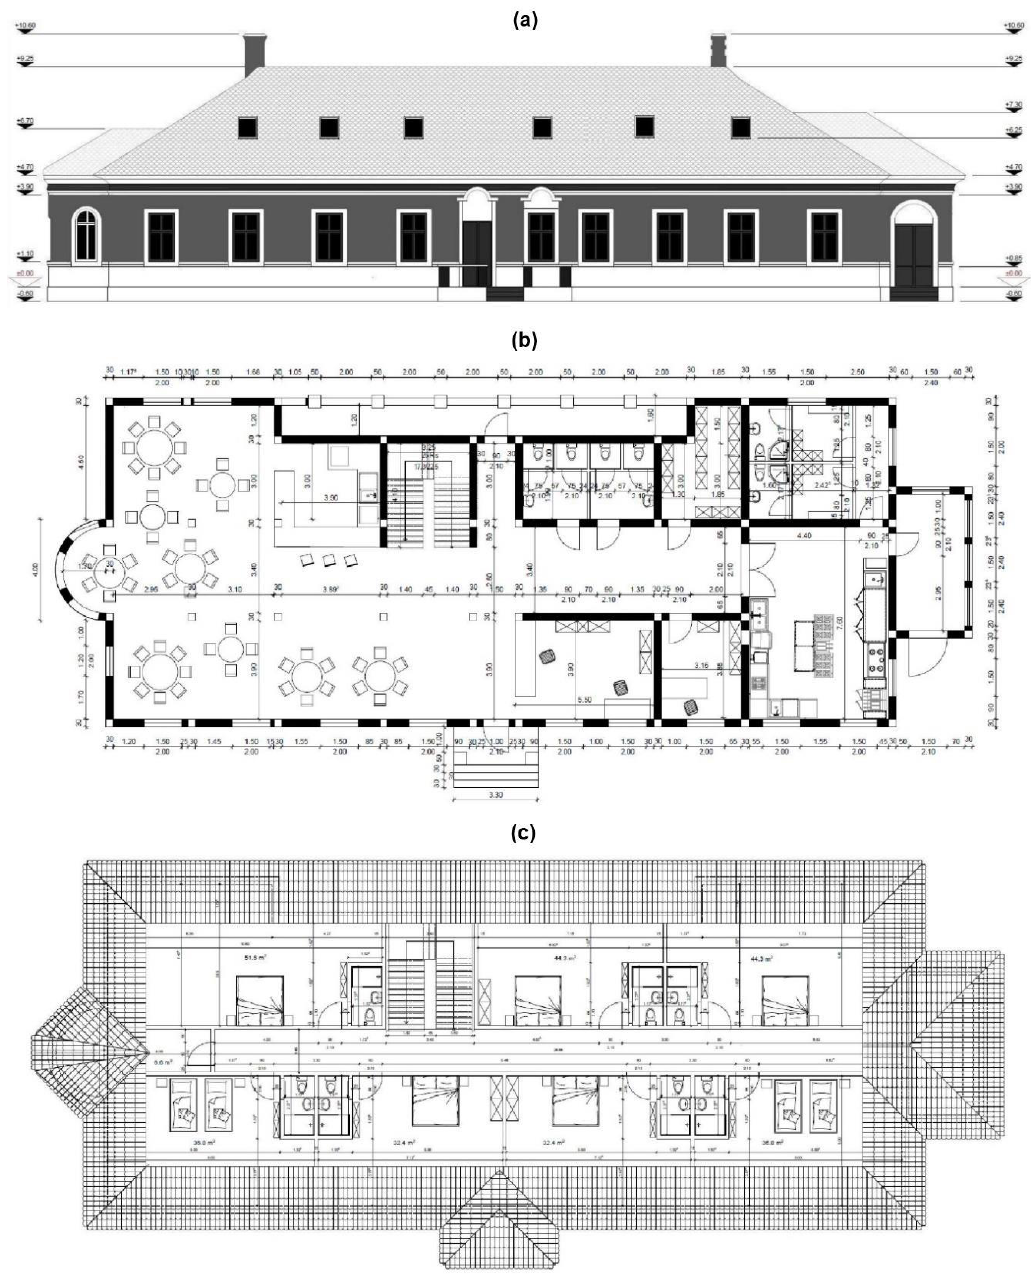
Figure 12. Proposed rehabilitation and restoration; ( a ) Reconstructed facade; ( b ) Envisioned ground floor; ( c ) Envisioned